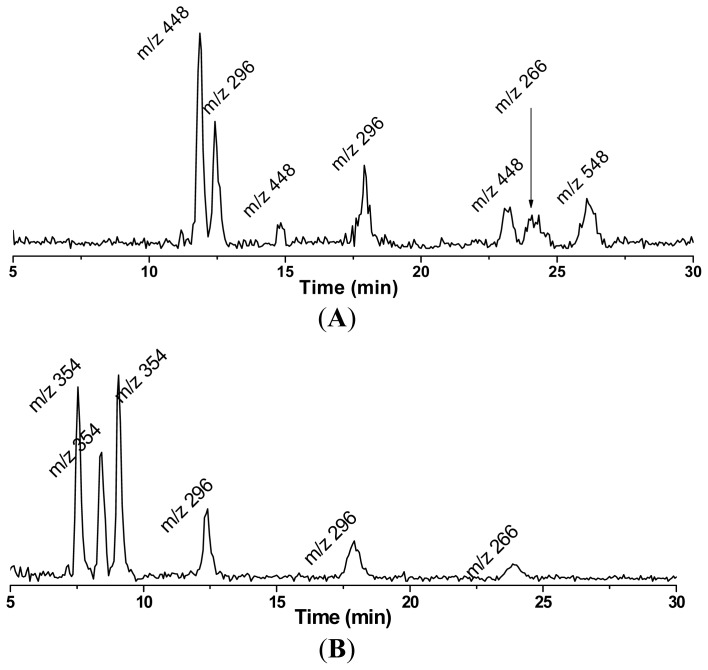
LC/MS chromatogram (EIC) of radical adducts from cellular PUFA peroxidation. (A) radical adducts from cells treated with AA; and (B) radical adducts from cells treated with DGLA. HCA-7 colony 29 cells were harvested and suspended in PBS. After being treated with high doses of POBN and PUFAs, the cells were incubated for 30 min. Then the reaction was stopped by mixing with ACN, and the supernatant was collected, centrifuged and condensed followed by LC/MS detection. In the COX/AA system, m/z 548, 448, 296, and 266 correspond to POBN/•C20H34O5, POBN/•C14H21O4, POBN/•C6H13O and POBN/•C5H11, respectively, which all come from C-15 oxygenation. In the COX/DGLA system, m/z 296 and 266 correspond to the common radical adducts POBN/•C6H13O and POBN/•C5H11 from C-15 oxygenation, while m/z 354 and 324 correspond to POBN/•C8H15O3 and POBN/•C7H13O2, two exclusive radical adducts from C-8 oxygenation in the COX/DGLA system.